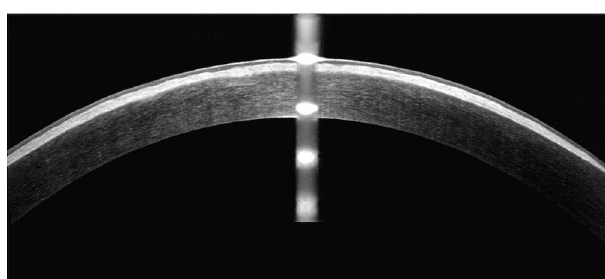
Figure 2. OCT findings in a patient with typical signs on the cornea. Significant opacities could be seen on the cornea.